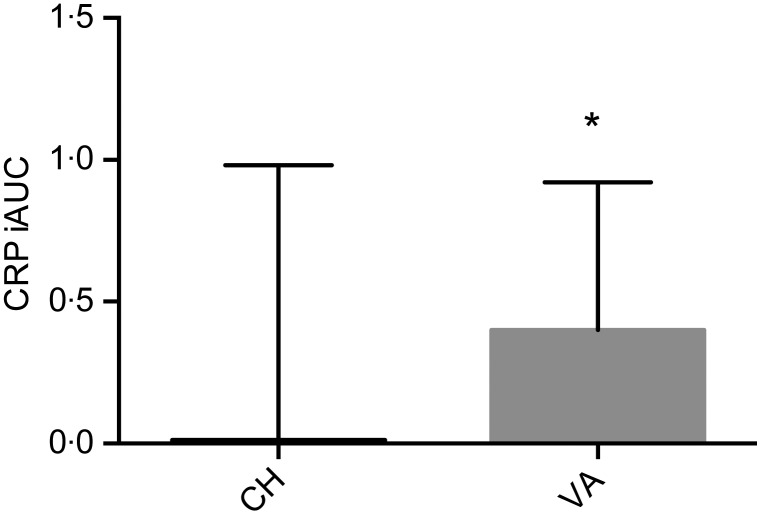
Postprandial serum C-reactive protein (CRP) concentrations over the 6 h
postprandial period after the Cheddar cheese (CH) and vegan alternative (VA) meals.
Values are means, with standard deviations represented by vertical bars. * The VA
meal resulted in a significantly greater overall CRP concentration
(P = 0·033) when compared with the CH meal. iAUC, incremental
AUC.